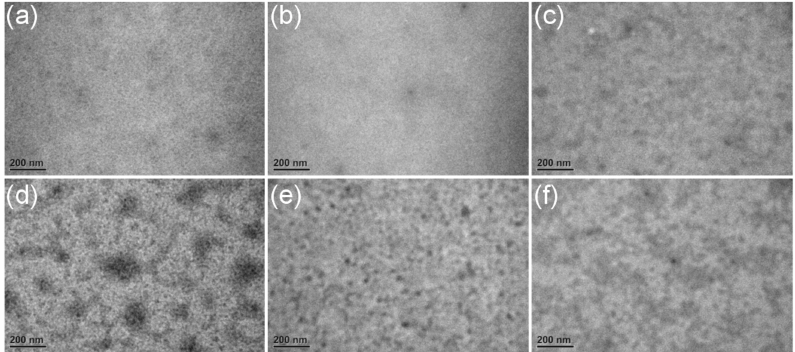
Figure 6. Transmission electron microscopy (TEM) images of polymer:PC 71 BM blend films